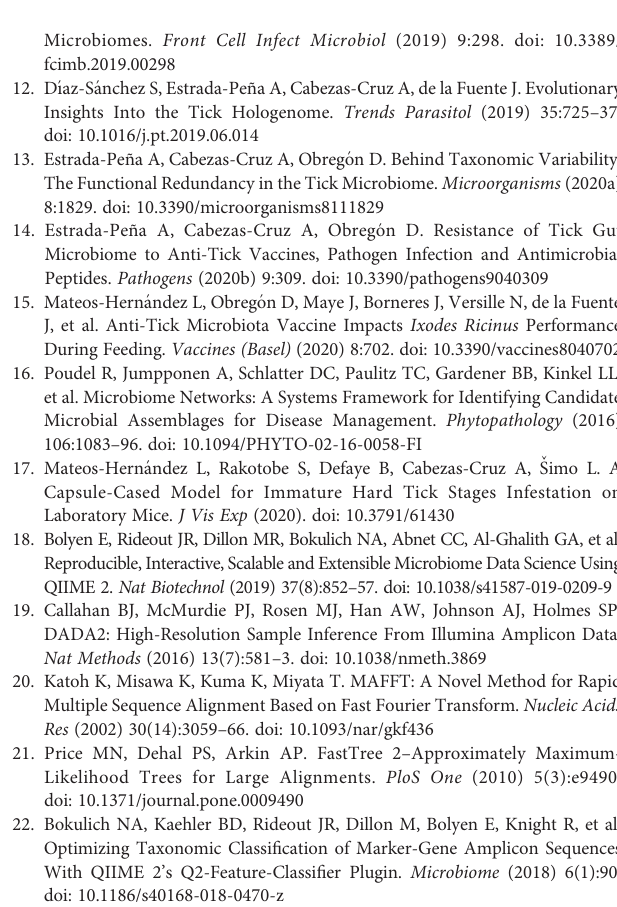
Supplementary Figure 3 | Immunocytochemistry of E. coli and L. mesenteroides using sera of immunized mice. Fixed E. coli (A) and L. mesenteroides (B) were stained with pooled sera of mice immunized with a live E. coli vaccine ( Escherichia ), live L . mesenteroides vaccine ( Leuconostoc ) or mock vaccine (PBS). Examples of positive reaction are displayed (white arrows in inserts). Alexa fl uor 488 conjugated anti-mouseantibody speci fi ctotheisotypesIgMandIgGwereusedasasecondary antibody. Negative control staining (Control) was performed using only the secondary antibody. Blue color indicates the nuclei visualized by 4 ’ ,6-diamidino-2- phenylindole (DAPI). Images were obtained using 63X magni fi cation and digital zoom. Scale bars are 2µm. Supplementary Figure 4 | Antibody response of mice vaccinated with live E. coli or L. mesenteroides. The levels of IgM and IgG speci fi c to (A) E. coli and (B) L. mesenteroides proteins were measured by semi-quantitative ELISA in sera of mice immunized with L. mesenteroides (blue) and E. coli (red), respectively, at different time points, d0, d14, d30 and d46. Antibody levels of bacteria-immunized micewerecompared withthoseofmock-immunized(green,PBS)mice.Meansand standard error values are shown. Results were compared by two-way ANOVA with Bonferroni testappliedfor comparisonsbetweencontrolandimmunized mice.(* p <